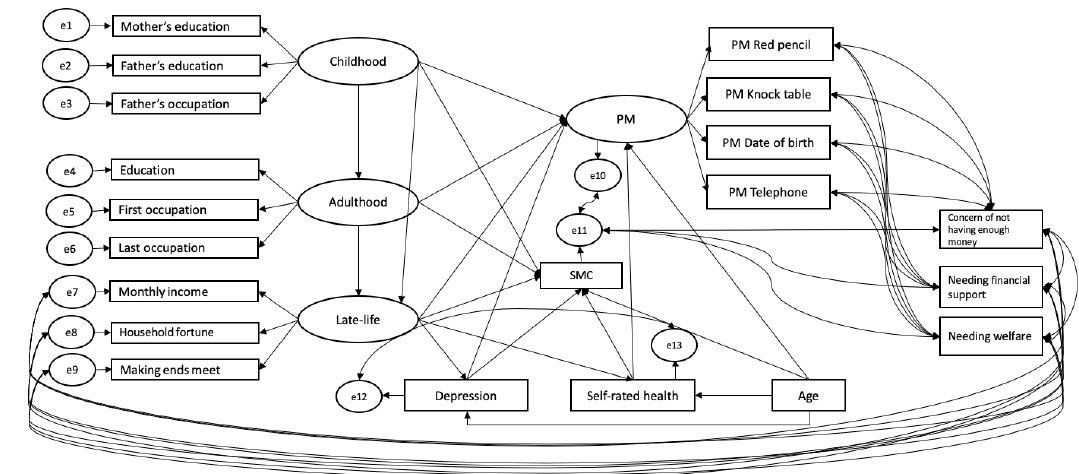
Figure 1. Structural equation model examining the carry-over effect of socioeconomic conditions through the life course and pathways of stages of life course socioeconomic conditions, age, depression and self-rated health on prospective memory (PM) and memory complaints (SMC). Latent variables are represented by ellipses, measured variables by rectangles, and corresponding errors of both latent and measured variables by